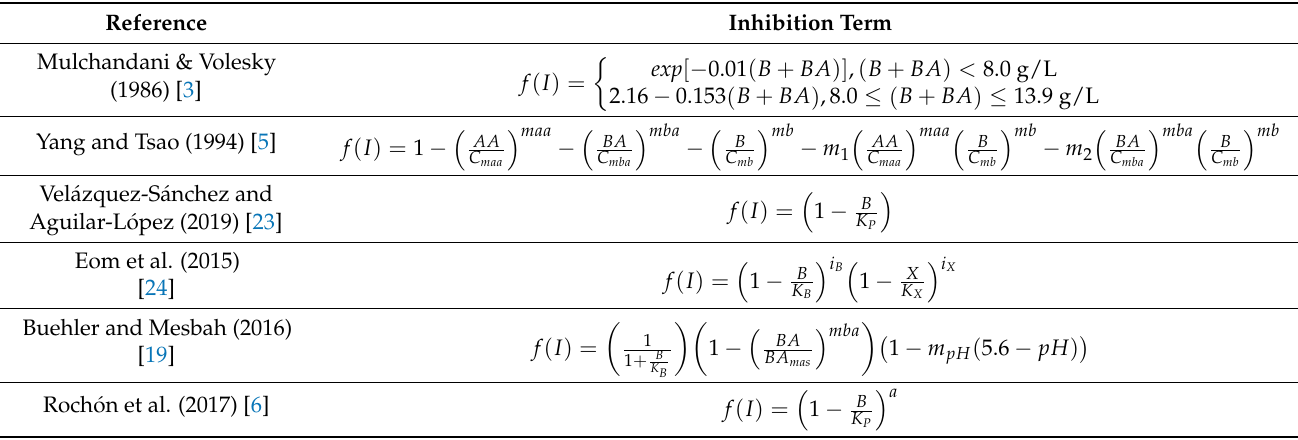
Table 1. Inhibition terms reported in the literature for ABE